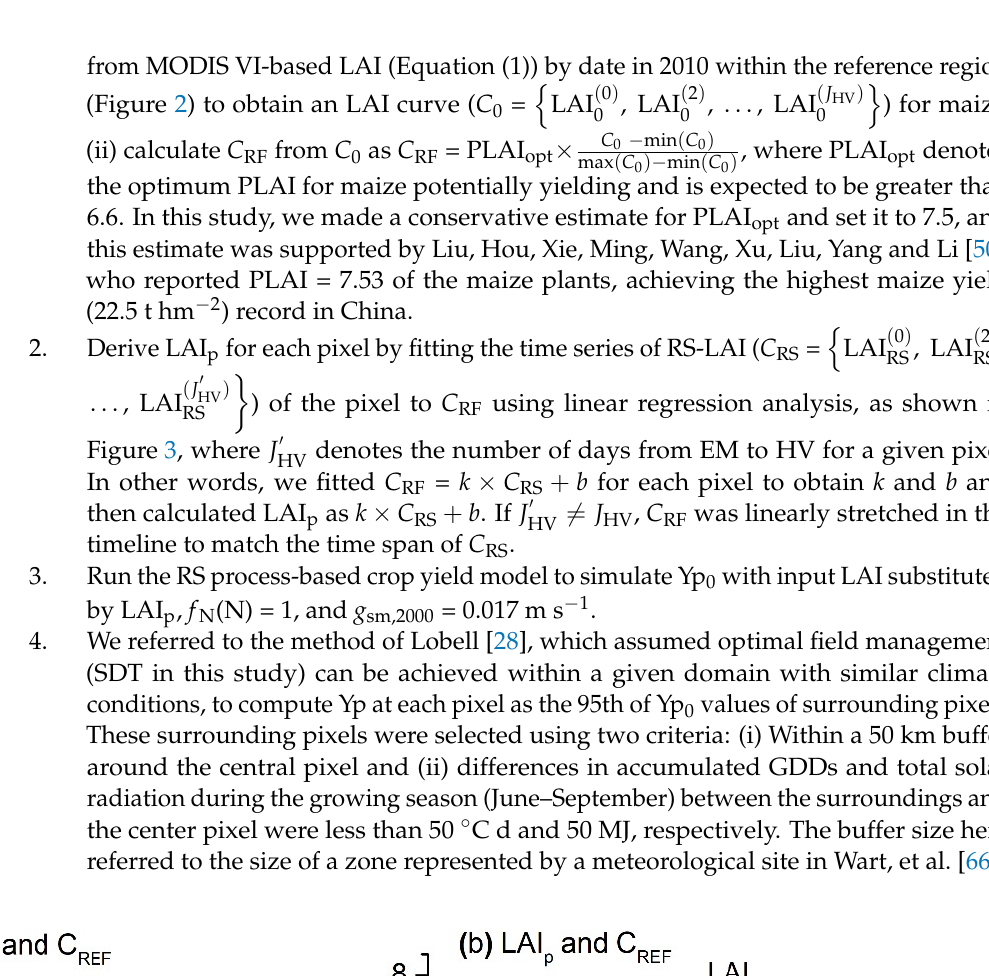
from MODIS VI-based LAI (Equation (1)) by date in 2010 within the reference region (Figure 2) to obtain an LAI curve ( C 0 =